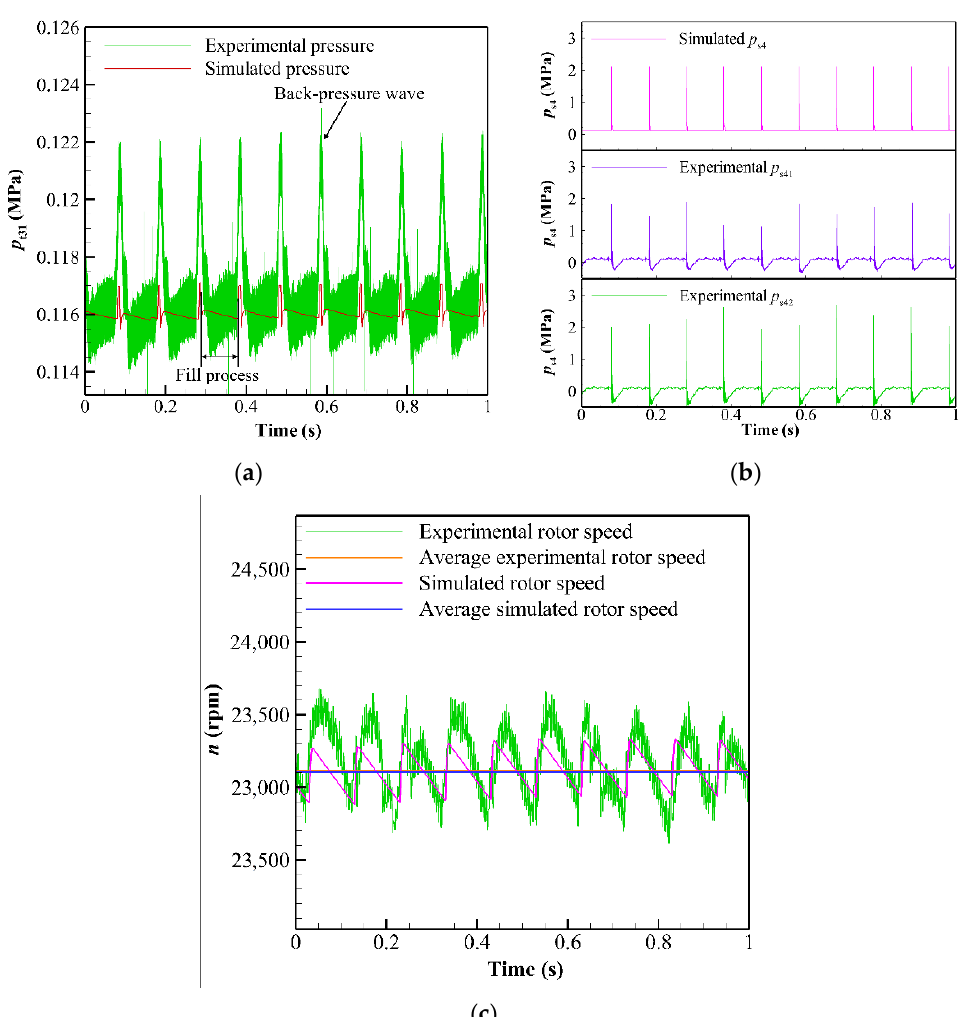
Figure 4. Comparisons of pressure and rotor speed for the experimental and numerical results. ( a ) Comparison of the total pressure. ( b ) Comparison of the static pressure. ( c ) Comparison of the rotor speed.